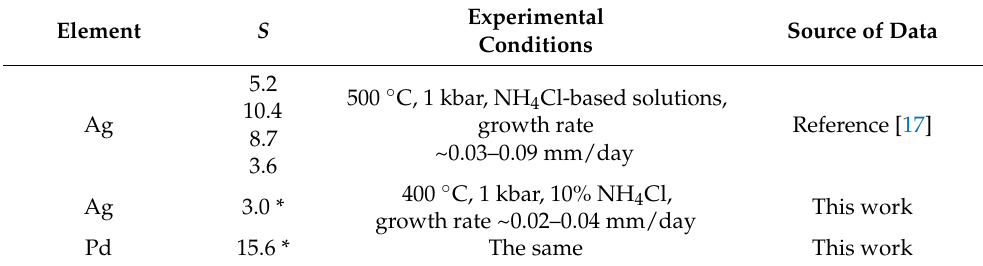
Table 6. Selectivity of pyrite NAP to Ag and Pd, according to experimental